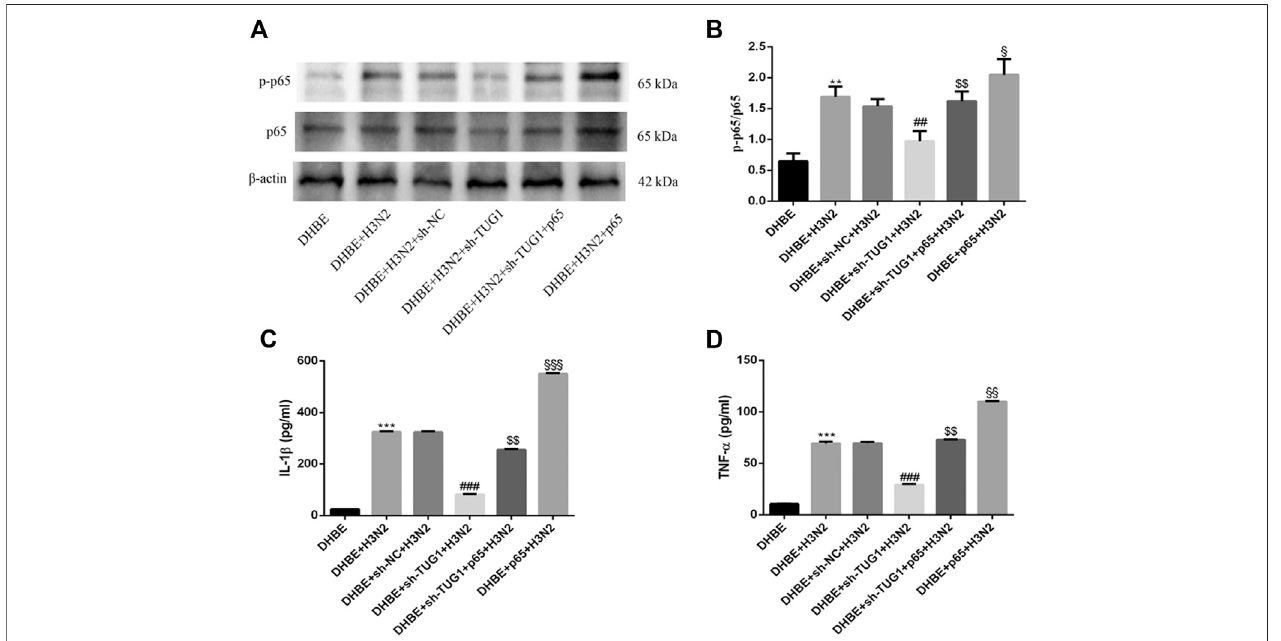
FIGURE 5 | Overexpression ofNF- κ Bp65 reversed the effects of lncRNA TUG1 knockdown in DHBE after infection with IAV. (A,B) The protein expressions of NF - κ Bp65andphospho-NF - κ Bp65wereanalyzedinDHBEpretreatedwithorwithoutsh-TUG1andNF- κ Bp65plasmidbyWesternblotting. (C,D) Theproteinexpressions of proin fl ammatory cytokines IL-1 β and TNF- α were analyzed in DHBE pretreated with or without sh-TUG1 and NF- κ Bp65 plasmid by ELISA ( ** p ＜ 0.01, *** p ＜ 0.001 as comparedtoDHBEgroup, ## p ＜ 0.01, ### p ＜ 0.001ascomparedtoDHBE+sh-NC+H3N2group, $$ p ＜ 0.01ascomparedtoDHBE+sh-TUG1+H3N2group, § p